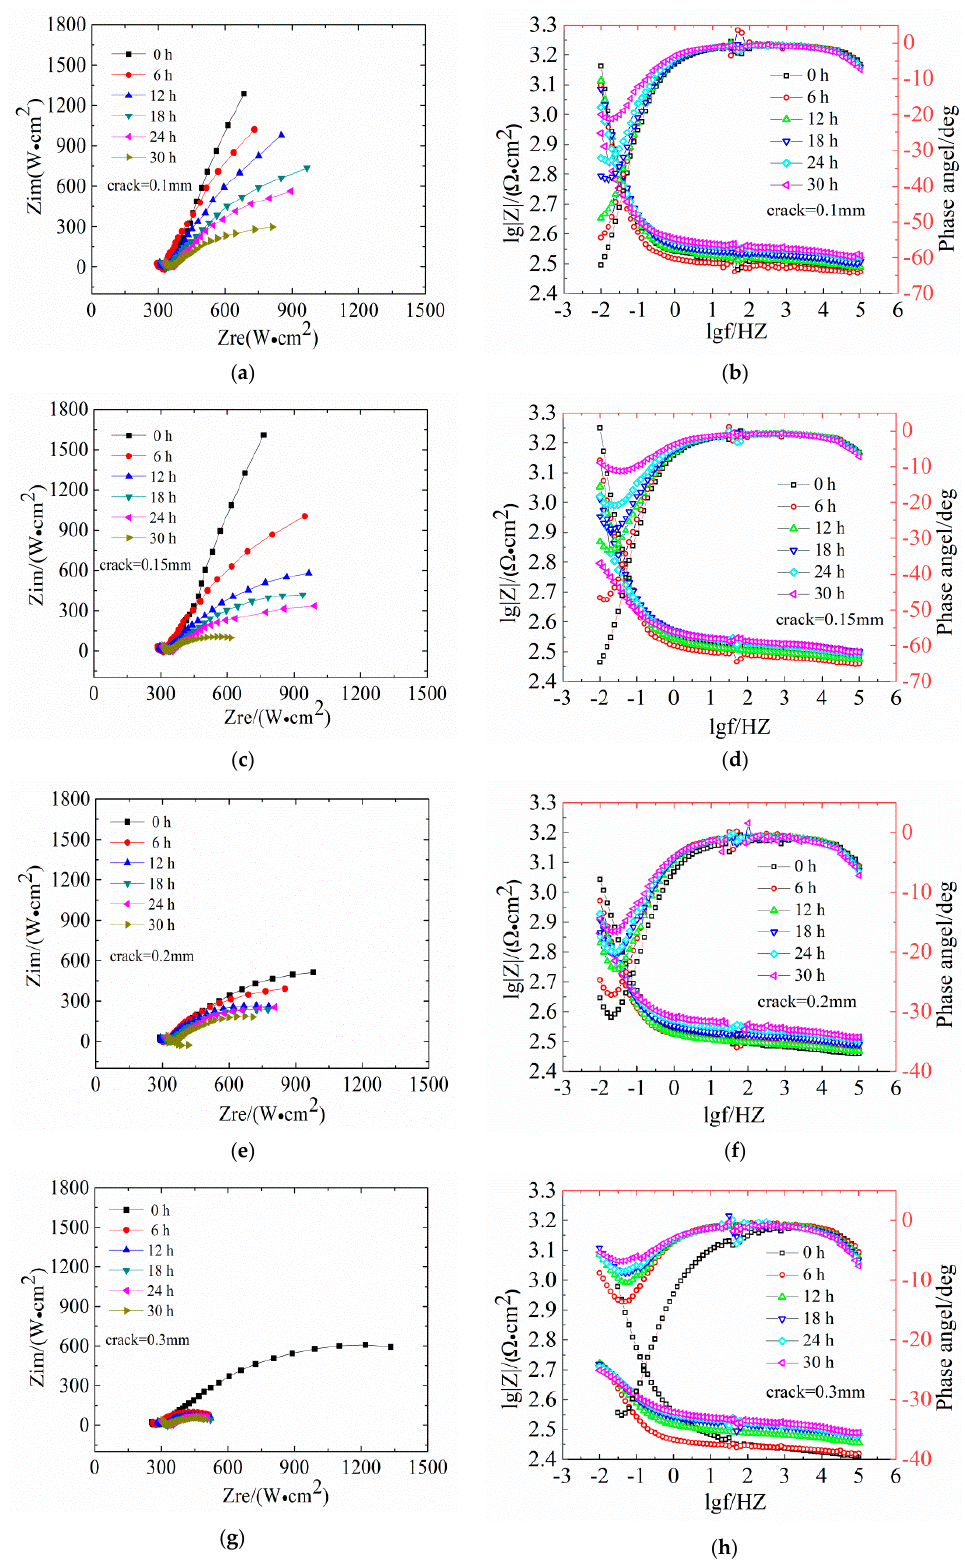
Figure 6. Evolutions of Nyquist plots and bode diagrams for reinforcement low carbon (LC) concrete with di ff erent crack widths. ( a , b ) Crack width = 0.10 mm; ( c , d ) Crack width = 0.15 mm; ( e , f ) Crack width = 0.20 mm; ( g , h ) Crack width = 0.30